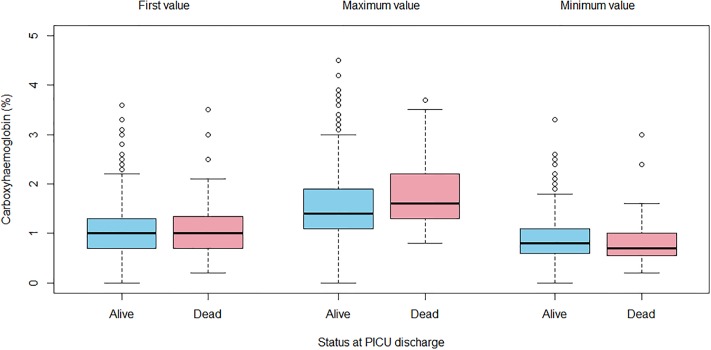
Box plot of measured COHb values and survival status at PICU discharge.The first, minimum and maximum COHb values (%) and the survival status at PICU discharge are represented. Neither the first nor the minimum COHb values predicted survival status at ICU discharge. The maximum COHb values were slightly better at predicting survival status at PICU discharge.